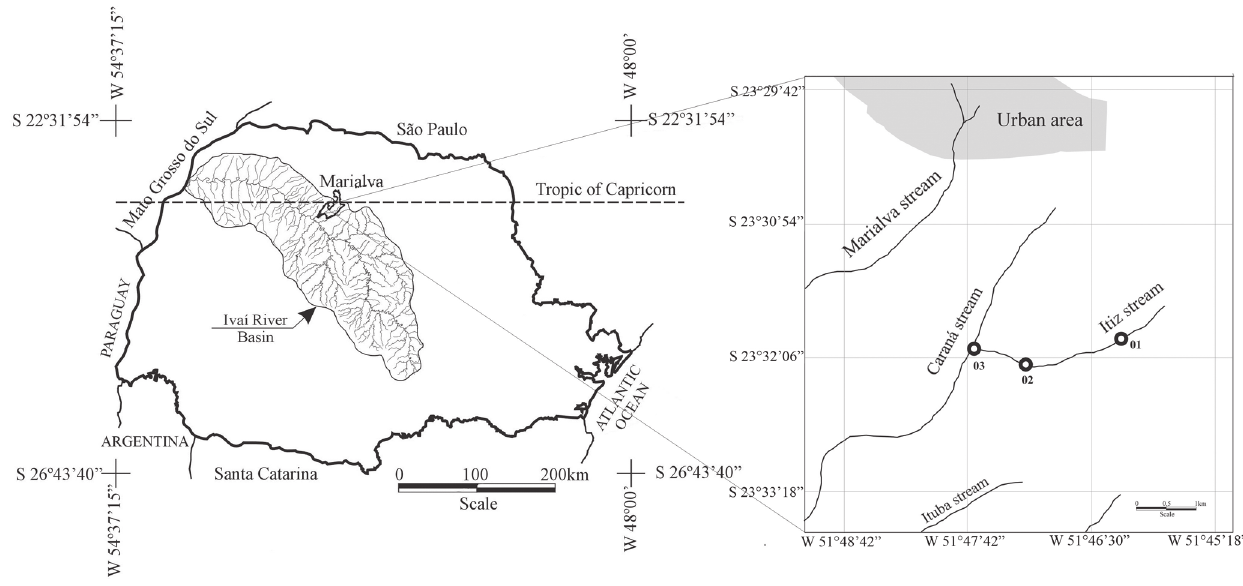
Fig. 1. Location of Itiz stream in the Ivaí River basin, state of Paraná, Brazil, indicating sampling sites (1, 2 and 3).